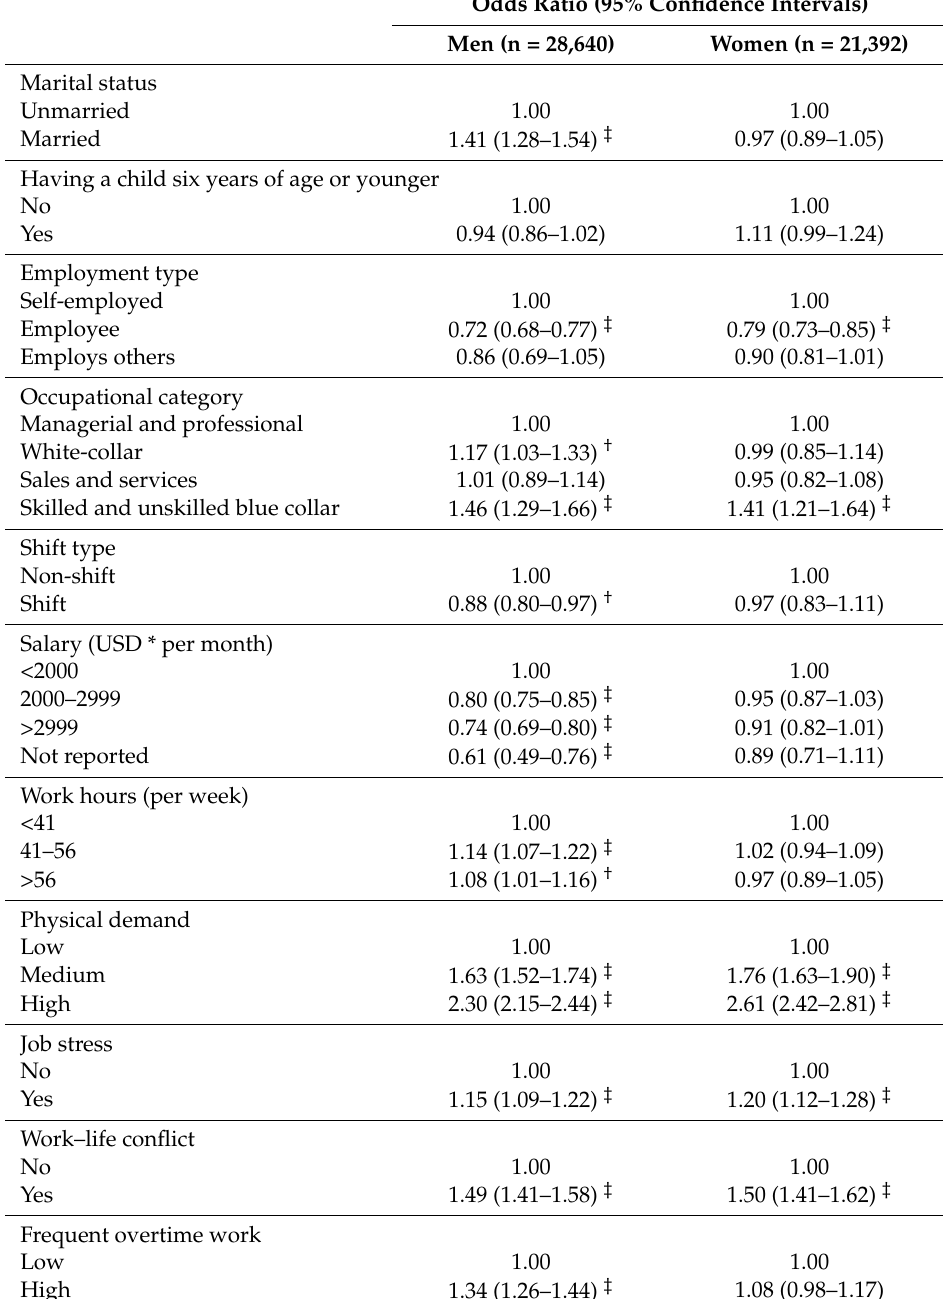
Table 2. Associations of work–life conflict and key covariates with musculoskeletal disorder among South Korean